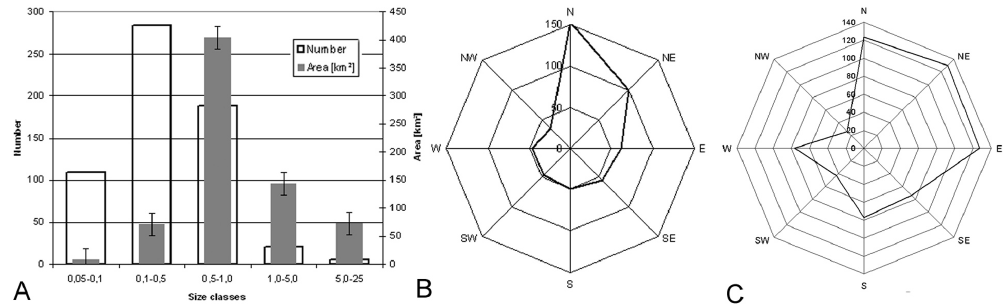
Fig. 5. Diagram showing the number and area covered for different size classes (A) , aspect of the glaciers – (B) : number, (C) : area).